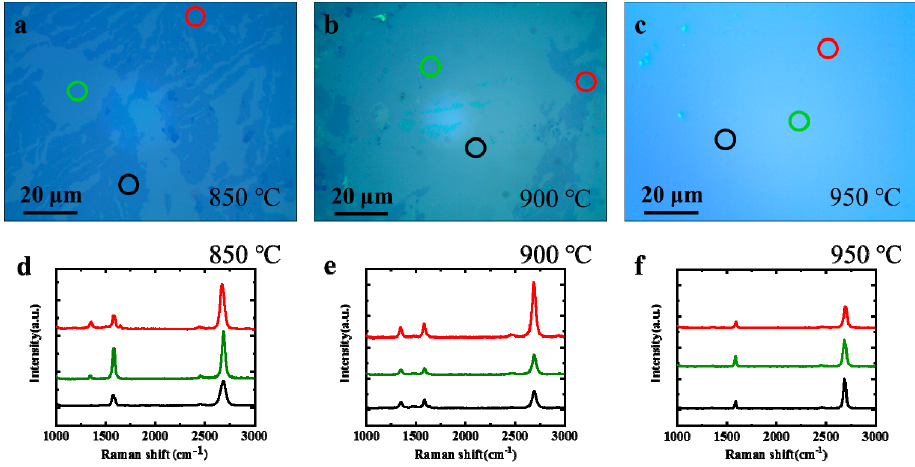
Figure 2. Characterization of graphene obtained at different temperatures. ( a – c ) OM images of transferred graphene on SiO 2 substrate at 850, 900 and 950 °C, respectively. ( d – f ) Raman spectra of as-grown graphene with different thicknesses at different temperatures. Raman curves correspond to the regions in ( a – c ) marked as circles with the same color as themselves.